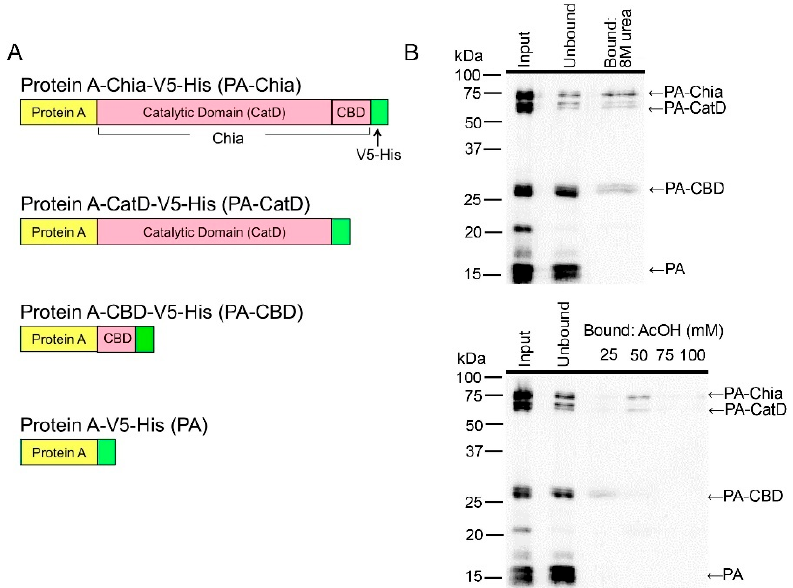
Figure 4. Binding of recombinant chicken full-length Chia as well as its catalytic domain (CatD) and chitin binding domain (CBD) are dissociated by acetic acid. ( A ) The schematic representations of the recombinant chicken Chia fusion proteins. ( B ) Western blot analysis of the recombinant proteins using anti-V5 antibody. Upper panel; Mixtures of the recombinant proteins were loaded onto a single chitin column. Bound proteins were eluted from the column with 8 M urea. Lower panel; Western blot analysis of the recombinant proteins. Bound proteins were eluted from the column with 25, 50, 75, and 100 mM acetic acid (stepwise elution). Arrows highlight the position of each fusion protein.